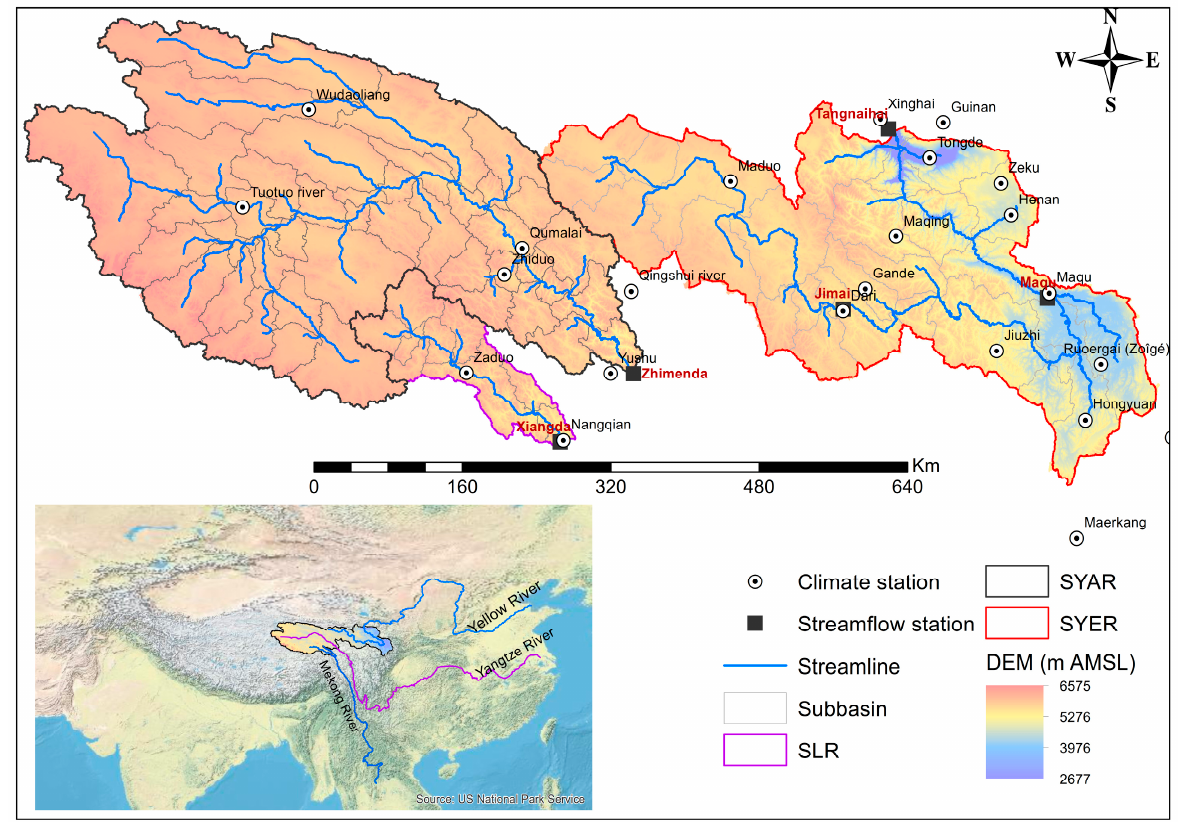
Figure 1. Location map of the Three-River Headwater Region showing streamflow gauges, meteor- ological stations, and elevation. SYER, source region of the Yellow River ; SYAR, source region of the Yangtze River; SLR, source region of the Lancang River.